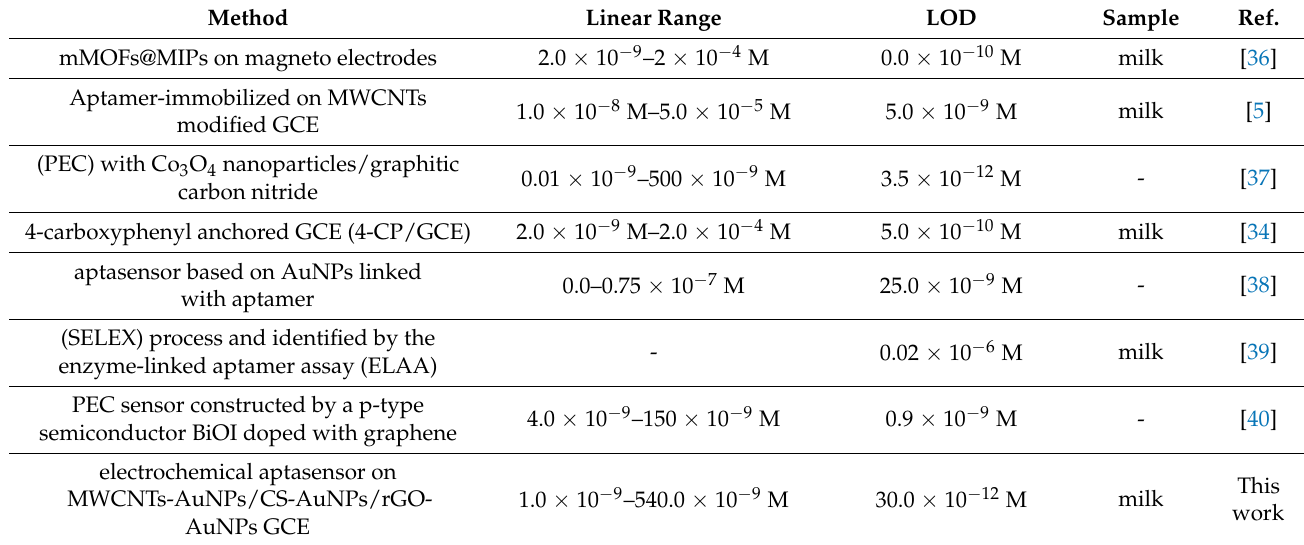
Table 2. Comparison of the proposed aptasensor with other